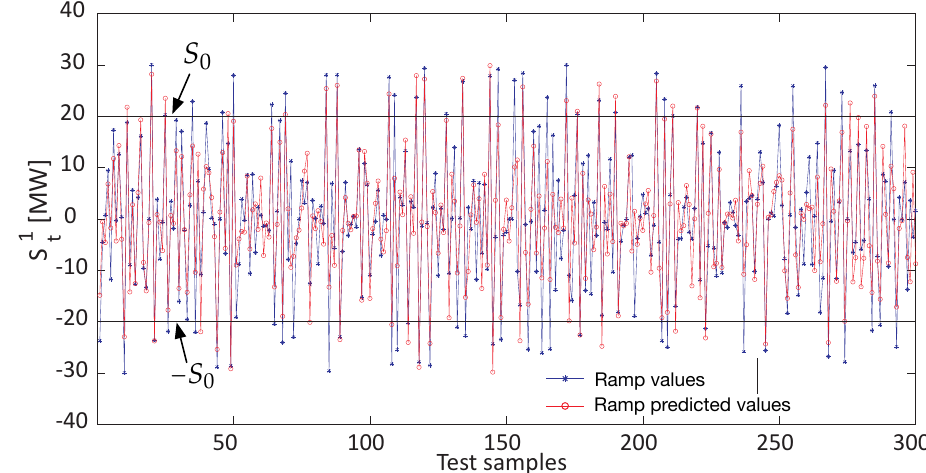
Figure 4. Prediction of the ramp function S 1 t ( Equation (1) ) when using the GPR in Wind Farm C. The predicted ramps series exhibits RMSE ≈ 4.75 MW, MAE ≈ 3.48 MW, s (+ramp) = 57.14%, s ( − ramp) = 61.05%, and s (no ramp) = 93.99% (see Table